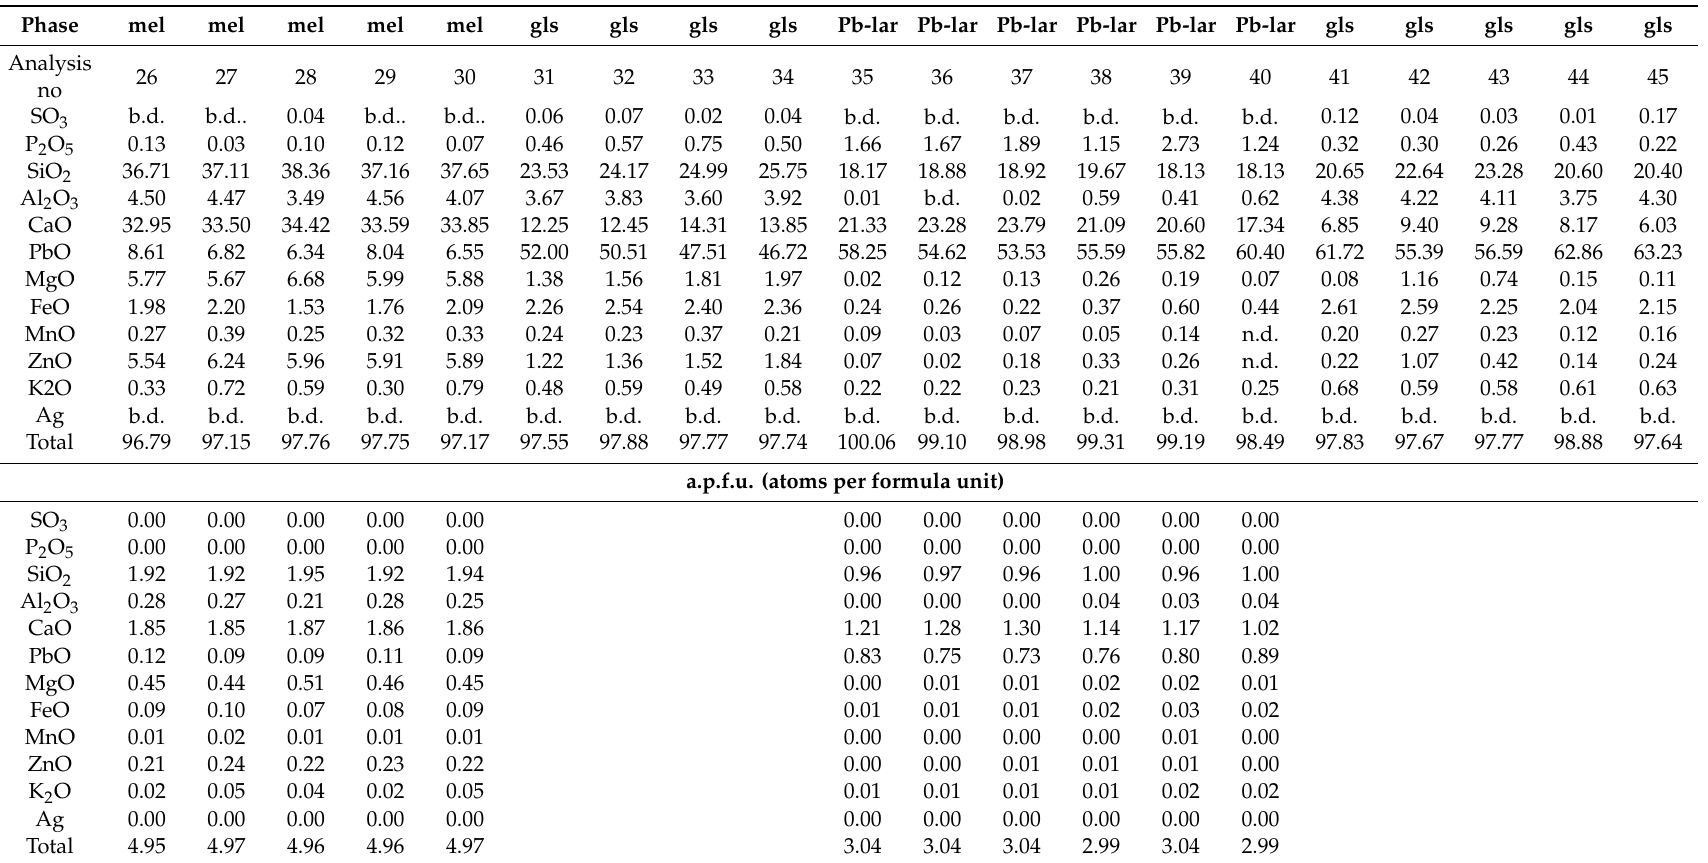
Table 3. EPMA analyses of silicates, alumosilicates, and glass building investigated slags